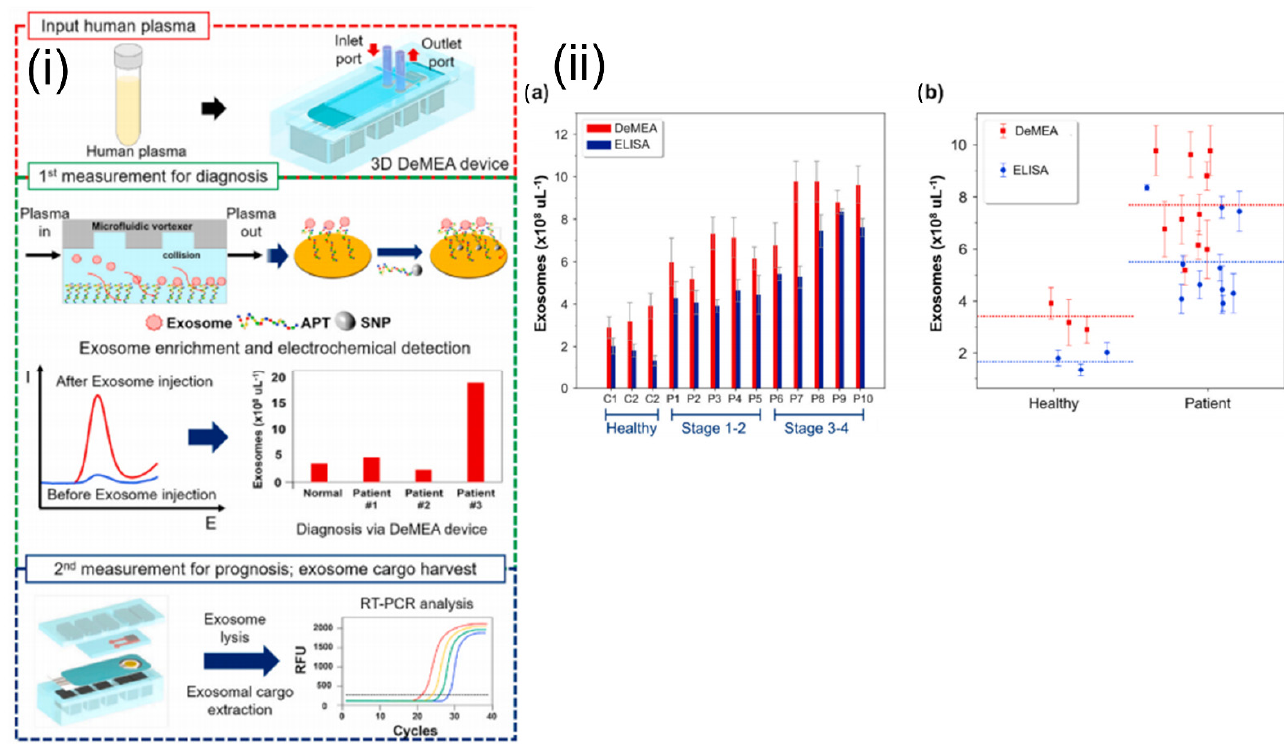
Figure 7. ( i ) Schematics and experimental workflow of the microfluidic platform with electrochemical aptasensor (DeMFA) for the quantification and cargo analysis of exosomes. ( ii ) DeMEA and ELISA quantification of exosomes derived from plasma samples of healthy and MCF-7 cancer cells represented in: ( a ) bar graph, ( b ) scatter graph (n = 3).Reprinted from Detachable microfluidic device implemented with electrochemical aptasensor (DeMEA) for sequential analysis of cancerous exosomes, Volume 169, Kashefi-Kheyrabadi et al., 2020, Page No. 112622, Copyright 2020, with permission from Elsevier.